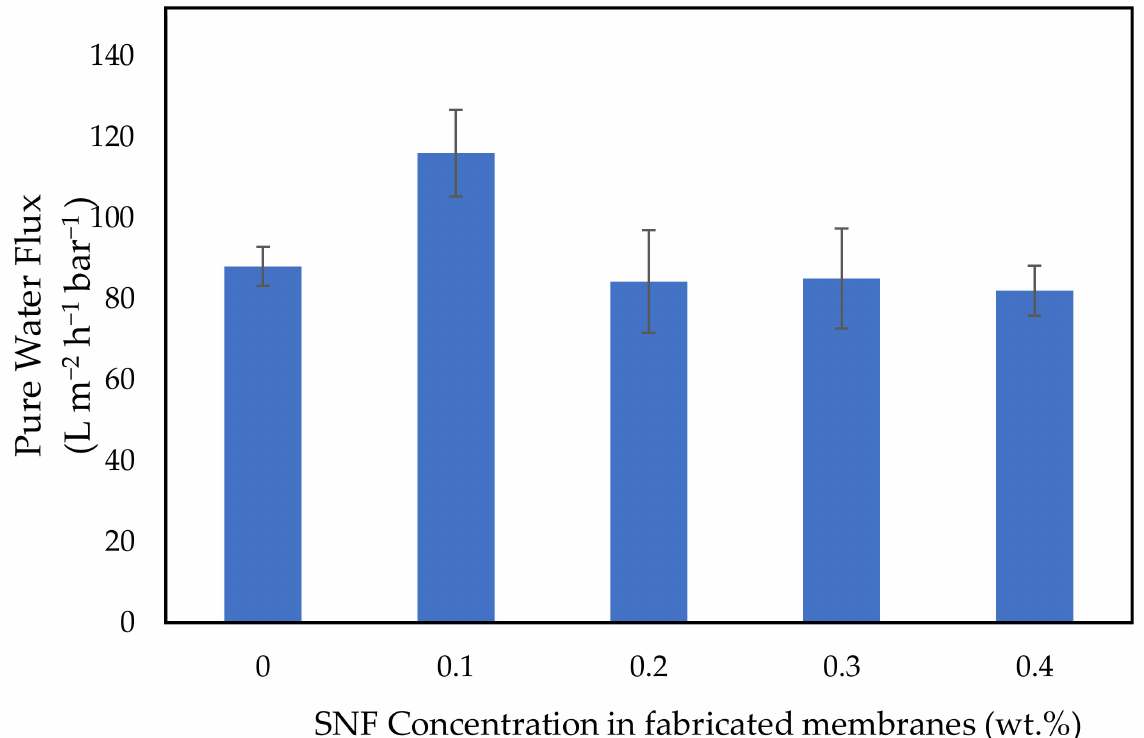
Figure 6. Pure water flux of the fabricated membranes at different SNF